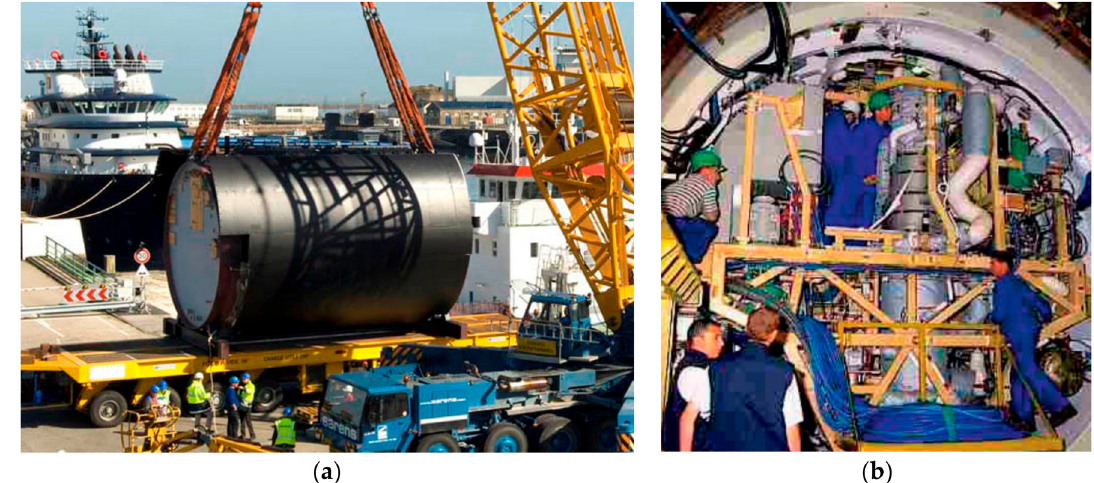
Figure 13. Photographs Showing Size of a MESMA Module and Its Inside. ( a ) Completed MESMA Module [69], ( b ) Inside of a MESMA module